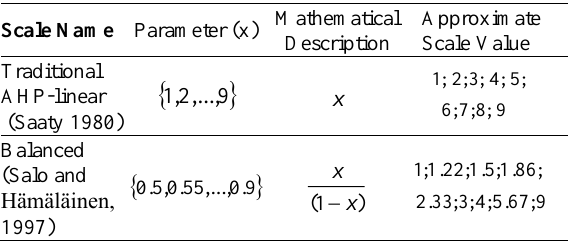
Table 2. Pairwise comparison decision